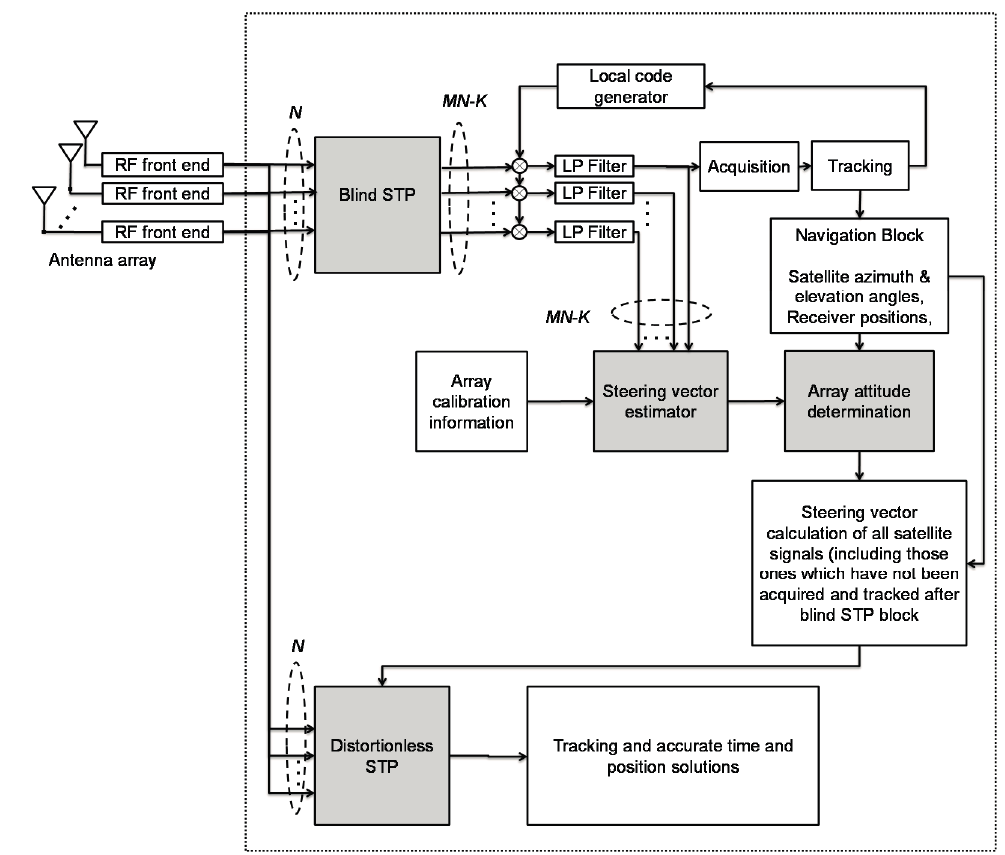
Figure 2. Structure of the proposed